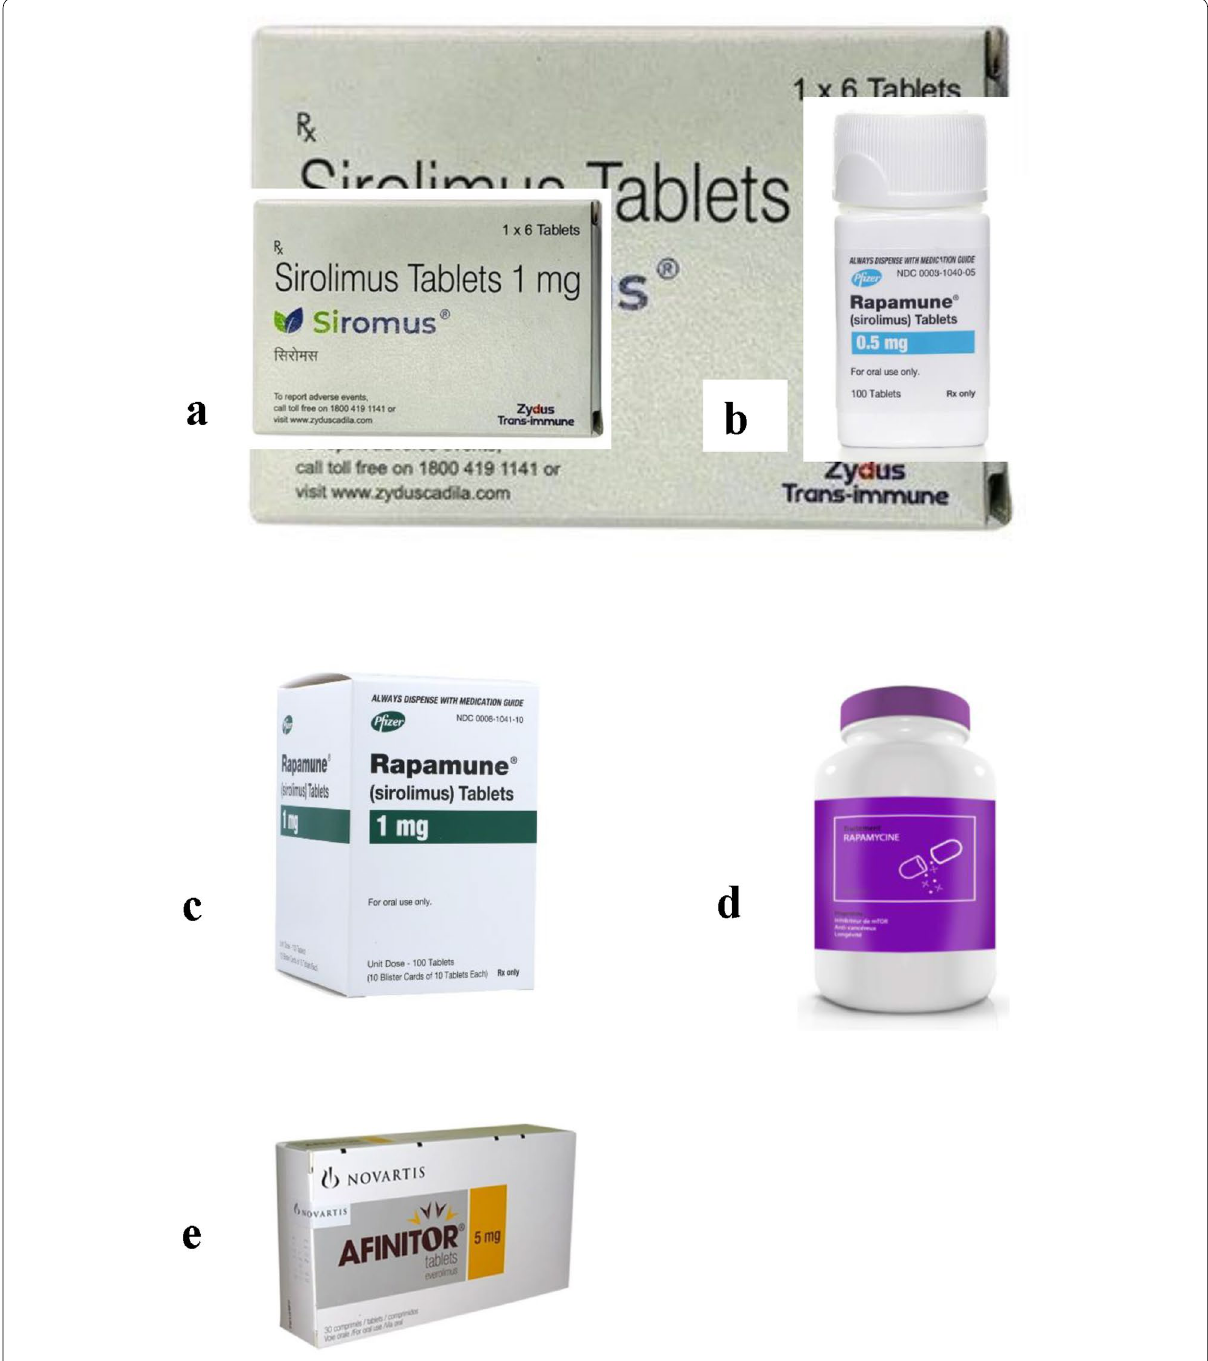
Fig. 5 Some rapamycin products. Sirolimus tablets 1 mg https:// www. india mart. com/ ( a ), Rapamune 0.5 mg https:// www. india mart. com/ ( b ), Sirolimus 1 mg https:// www. wiitus. com/ ( c ), Rapamycine https:// www. longl ongli fe. org/ ( d ), and Afinitor (5 mg) ( e